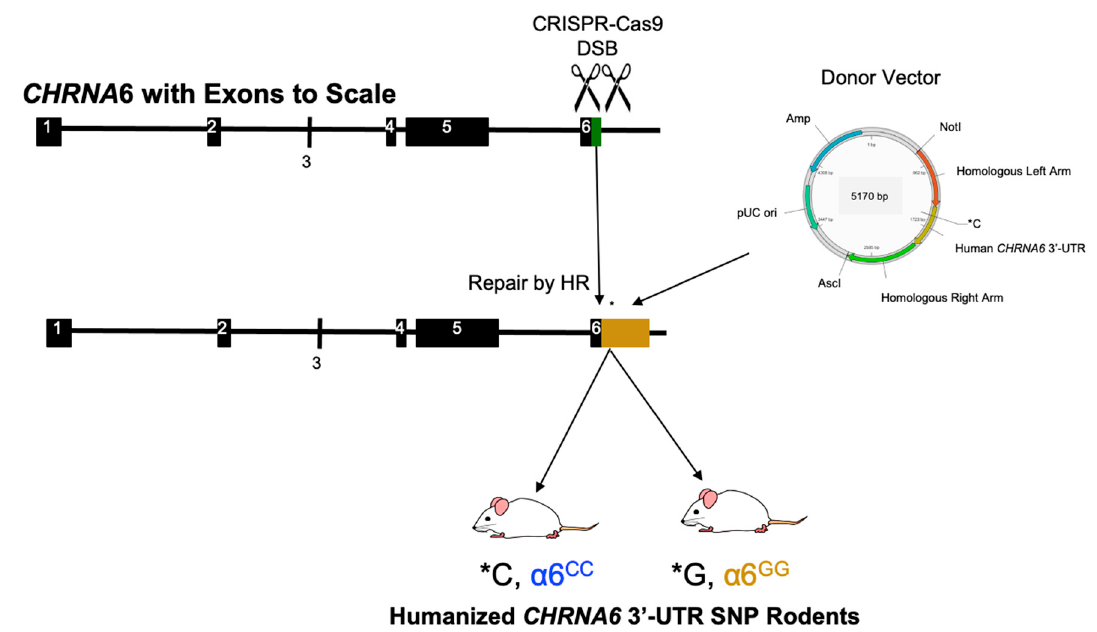
Figure 1. Generation of Humanized CHRNA6 3 ′ -Untranslated Region (UTR) SNP Rodents. Site- specific double-stranded breaks (DSB) were introduced at the CHRNA6 3 ′ -UTR of the wild-type (WT) Sprague-Dawley (green, 95 nucleotides) via Clustered Regularly Interspaced Short Palindromic Repeats (CRISPR)/CRISPR-associated (Cas9) endonuclease methods followed by the insertion of a donor vector through homologous recombination (HR) DNA repair. A human CHRNA6 3 ′ -UTR (gold, 559 nucleotides) containing either the minor or major SNP allele at nucleotide position 123 (SNP location indicated by *C or *G, respectively) was introduced by a donor vector. F2 offspring resulting from confirmed founders and F1 crossbred pups resulted in homozygous major ( α 6 GG ) and homozygous minor ( α 6 CC ) humanized CHRNA6 3 ′ -UTR SNP rodents. Ampicillin (Amp); base pair (bp); AscI and NotI: restriction enzyme recognition sites; plasmid origin of replication (pUC ori).